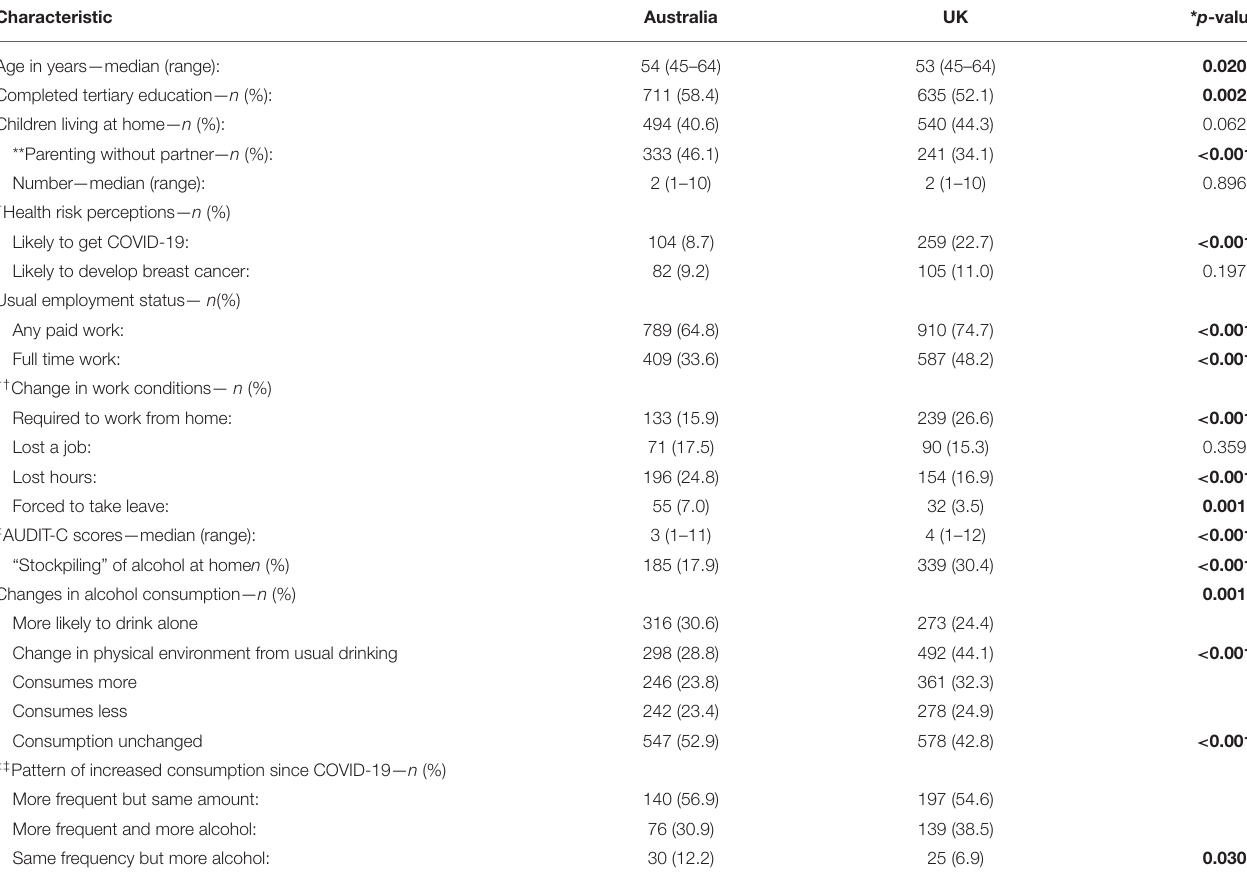
TABLE 1 | Characteristics of Australian and UK participants at entry ( N = 2,437).